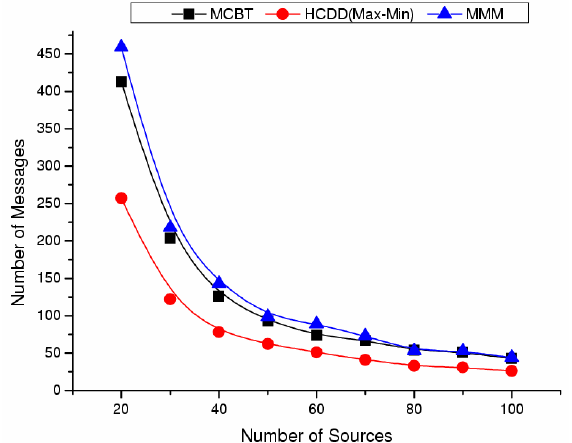
Figure 10. Maximum number of transmission